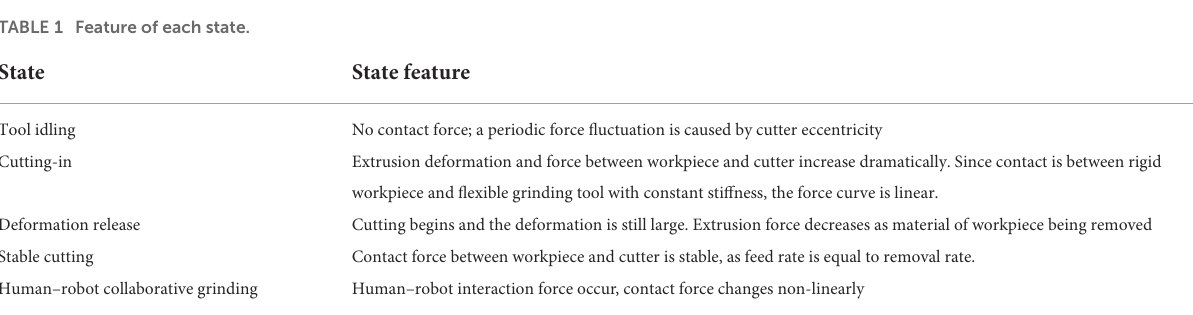
TABLE 1 Feature of each